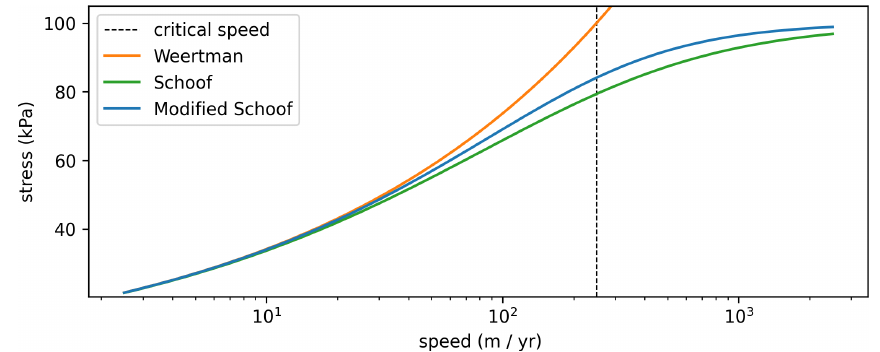
Figure 2. The Weertman, Schoof, and modified Schoof sliding law of Eq. (45). The critical speed and shear stress are u c = 250myr − 1 and τ c = 100kPa.